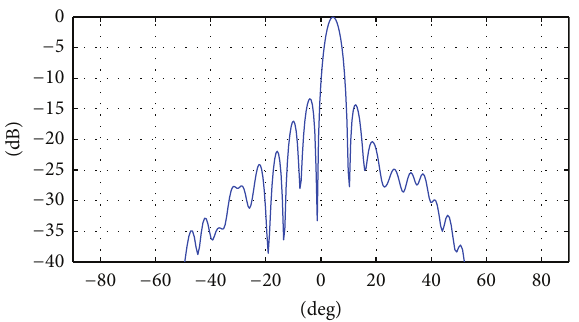
Figure 9: Far-field pattern of failure-free slotted waveguide array (result from planar near-field to far-field transformation).